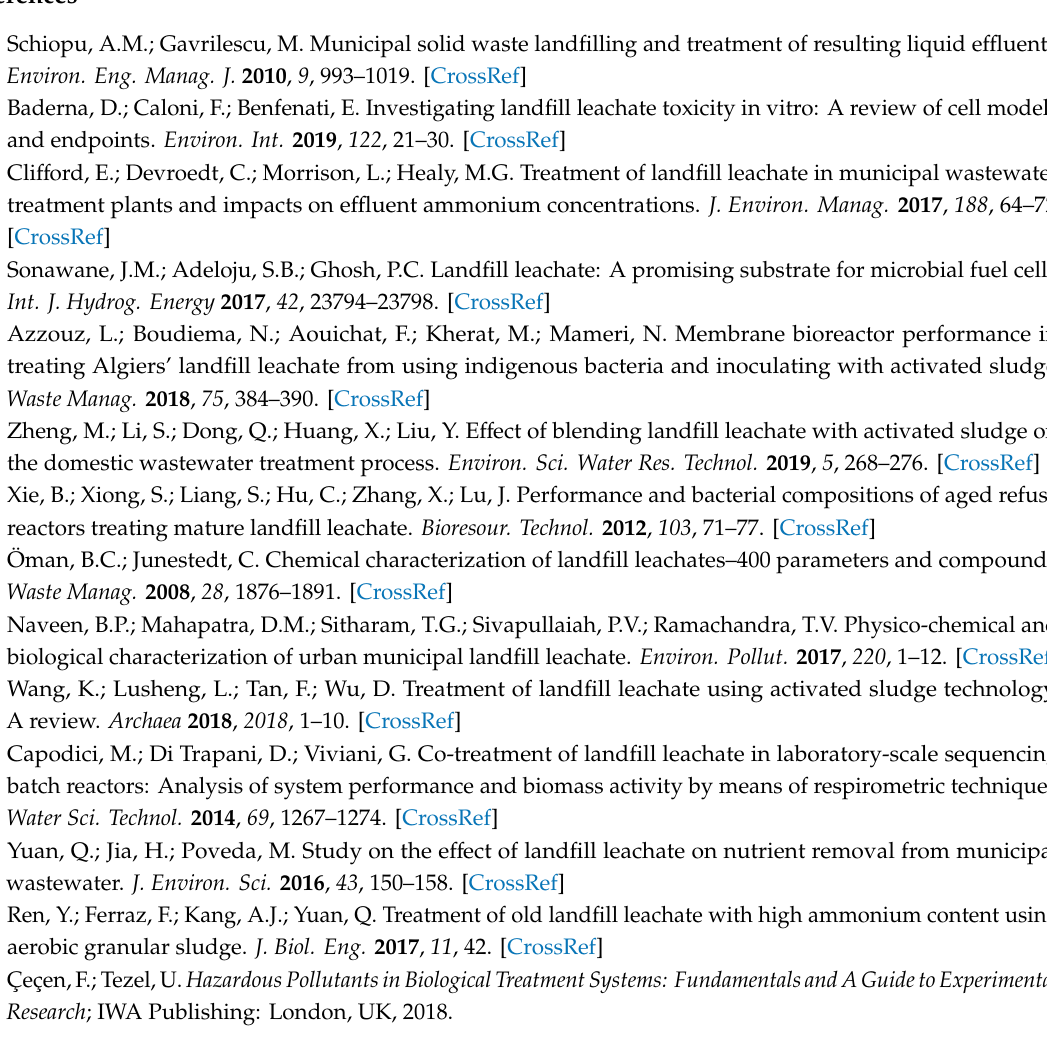
Table S1: Composition of media used for characteristics of bioaugmentation candidates (section Materials and Methods), Table S2: General characteristics of genomes of P. putida OR45a and P. putida KB3, Table S3: A distribution of the genes associated with the clusters of orthologous groups (COG) categories in the genomes of P. putida OR45a and P. putida KB3, Table S4: Description of genes responsible for selected features of P. putida KB3 and P. putida